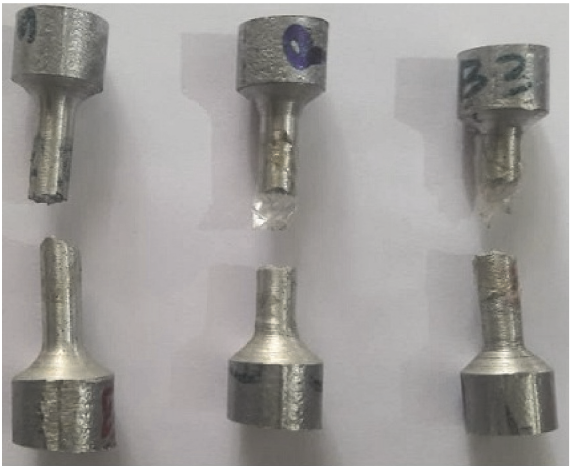
Figure 4: Tensile